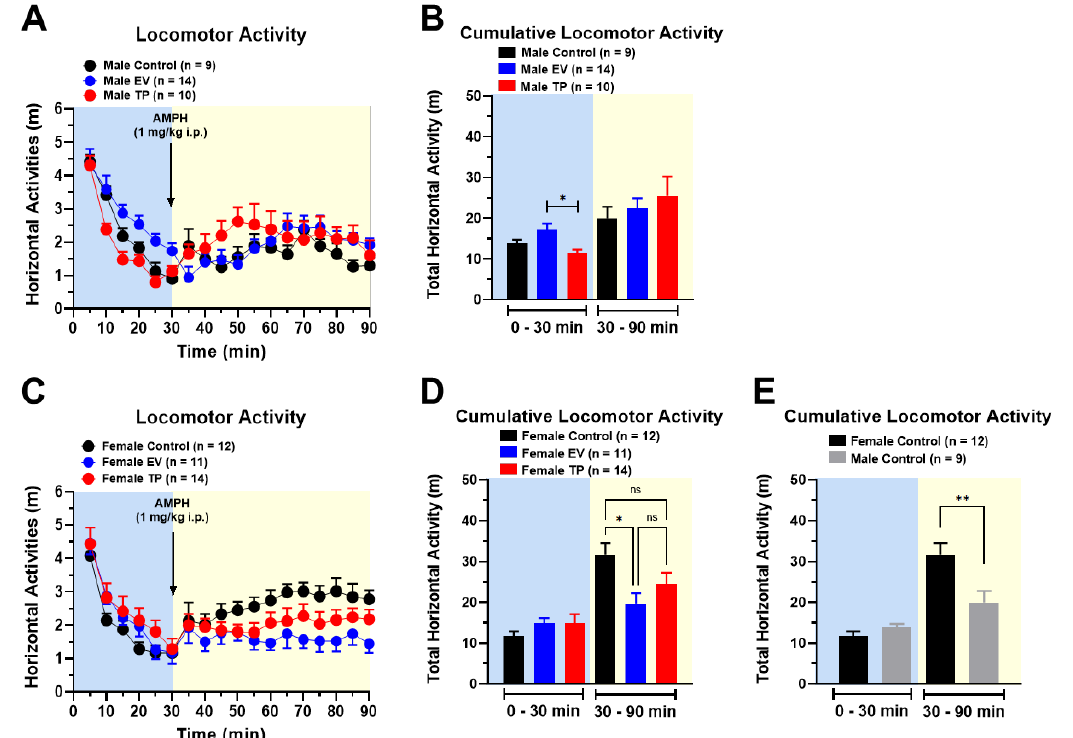
Figure 2. Basal and AMPH-induced locomotor activity (1 mg/kg i.p.) in male and female rats neonatally treated with saline, EV and TP. In panels ( A , C ), the time course of basal and AMPH-induced locomotor activity is shown, expressed as distance traveled (m). Panels ( B , D ) show cumulative basal (0–30 min) and AMPH-induced (30–90 min) locomotor activity in male and female rats. Panel ( E ) compares the cumulative locomotor activity of control males and females, neonatally treated with saline. Data are expressed as mean ± SEM (mean standard error), and the statistical analysis used was one-way ANOVA (* p < 0.05; ** p < 0.01).